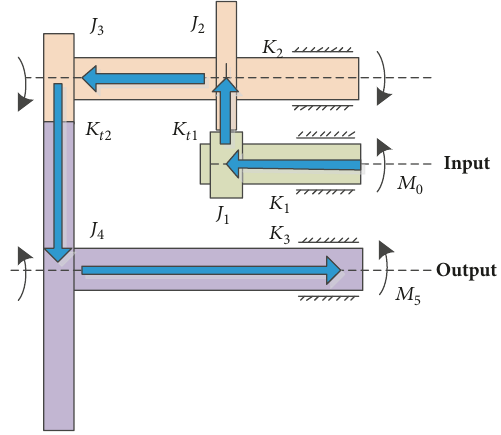
Figure 1: Diagram of two-stage gear